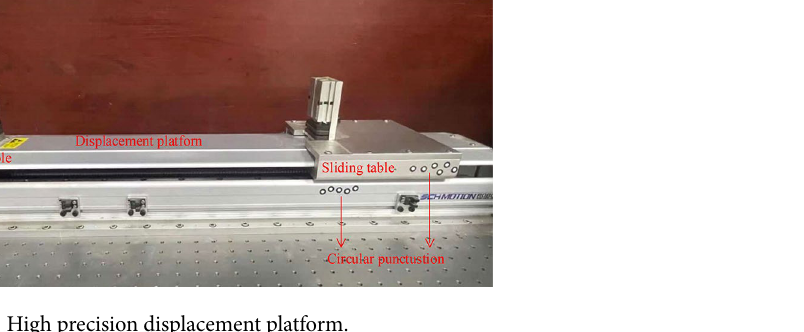
Figure 6. High precision displacement